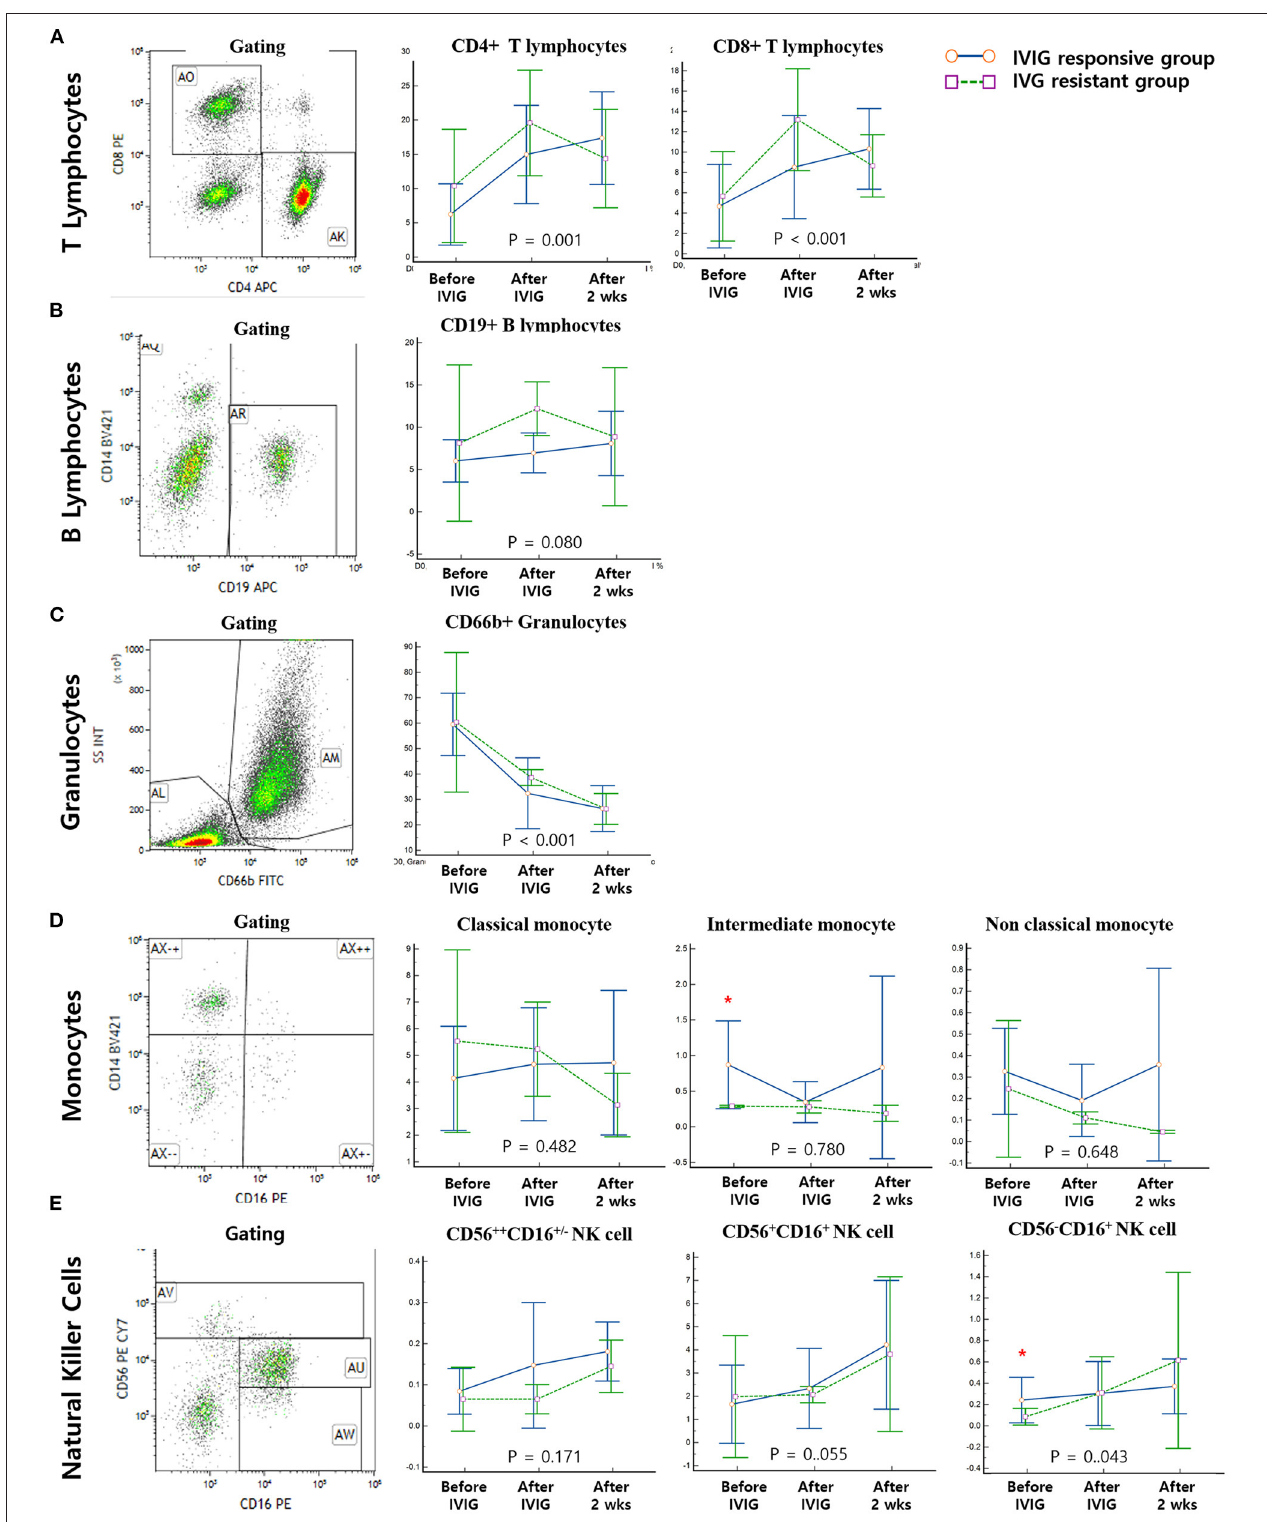
FIGURE 1 | Gating and serial measurements of immune cells. Solid blue lines represent the immunoglobulin (IVIG)-responsive group and dotted green lines represent the IVIG-resistant group. All of the enrolled patients underwent serial measurements of immune cells before IVIG infusion and immediately and 2 weeks after IVIG infusion. (A) Both CD4 + and CD8 + T lymphocytes significantly changed throughout the course of the disease ( P = 0.001 and P < 0.001, respectively); however, no